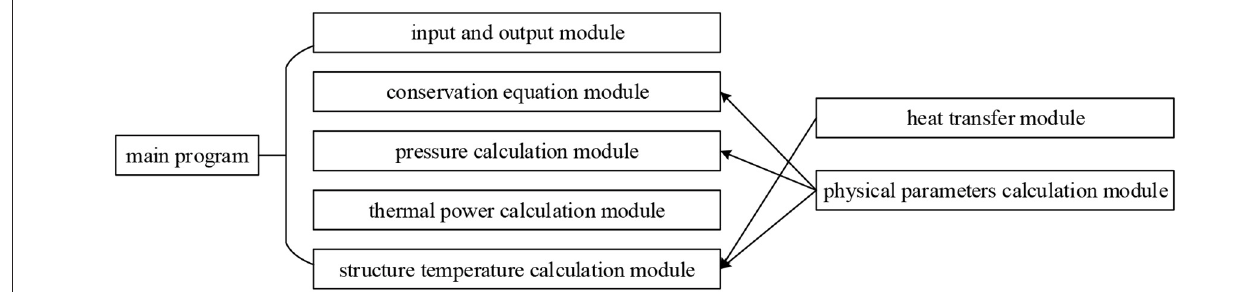
FIGURE 1 | Module call diagram of SCTRAN.